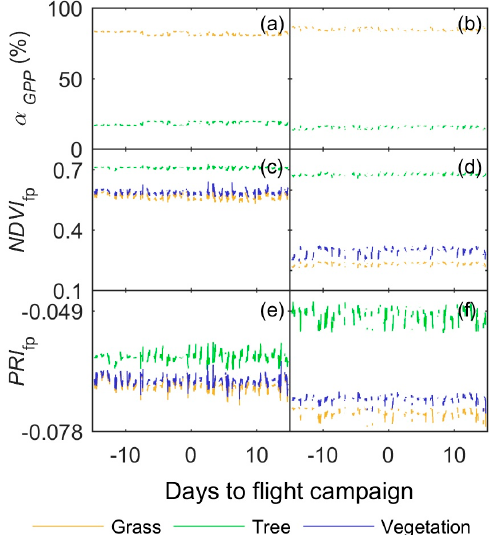
Figure 4. Footprint induced variability in optical signals acquired over the control (CTRL) tower on: 23 April 2015 ( a , c , e ); and 3 July 2015 ( b , d , f ), on the relative area of the different vegetation covers contributing to: GPP hh ( a , b ); the Normalized Vegetation Index (NDVI fp ) ( c , d ); and the Photochemical Reflectance Index ( PRI fp ) ( e , f ).